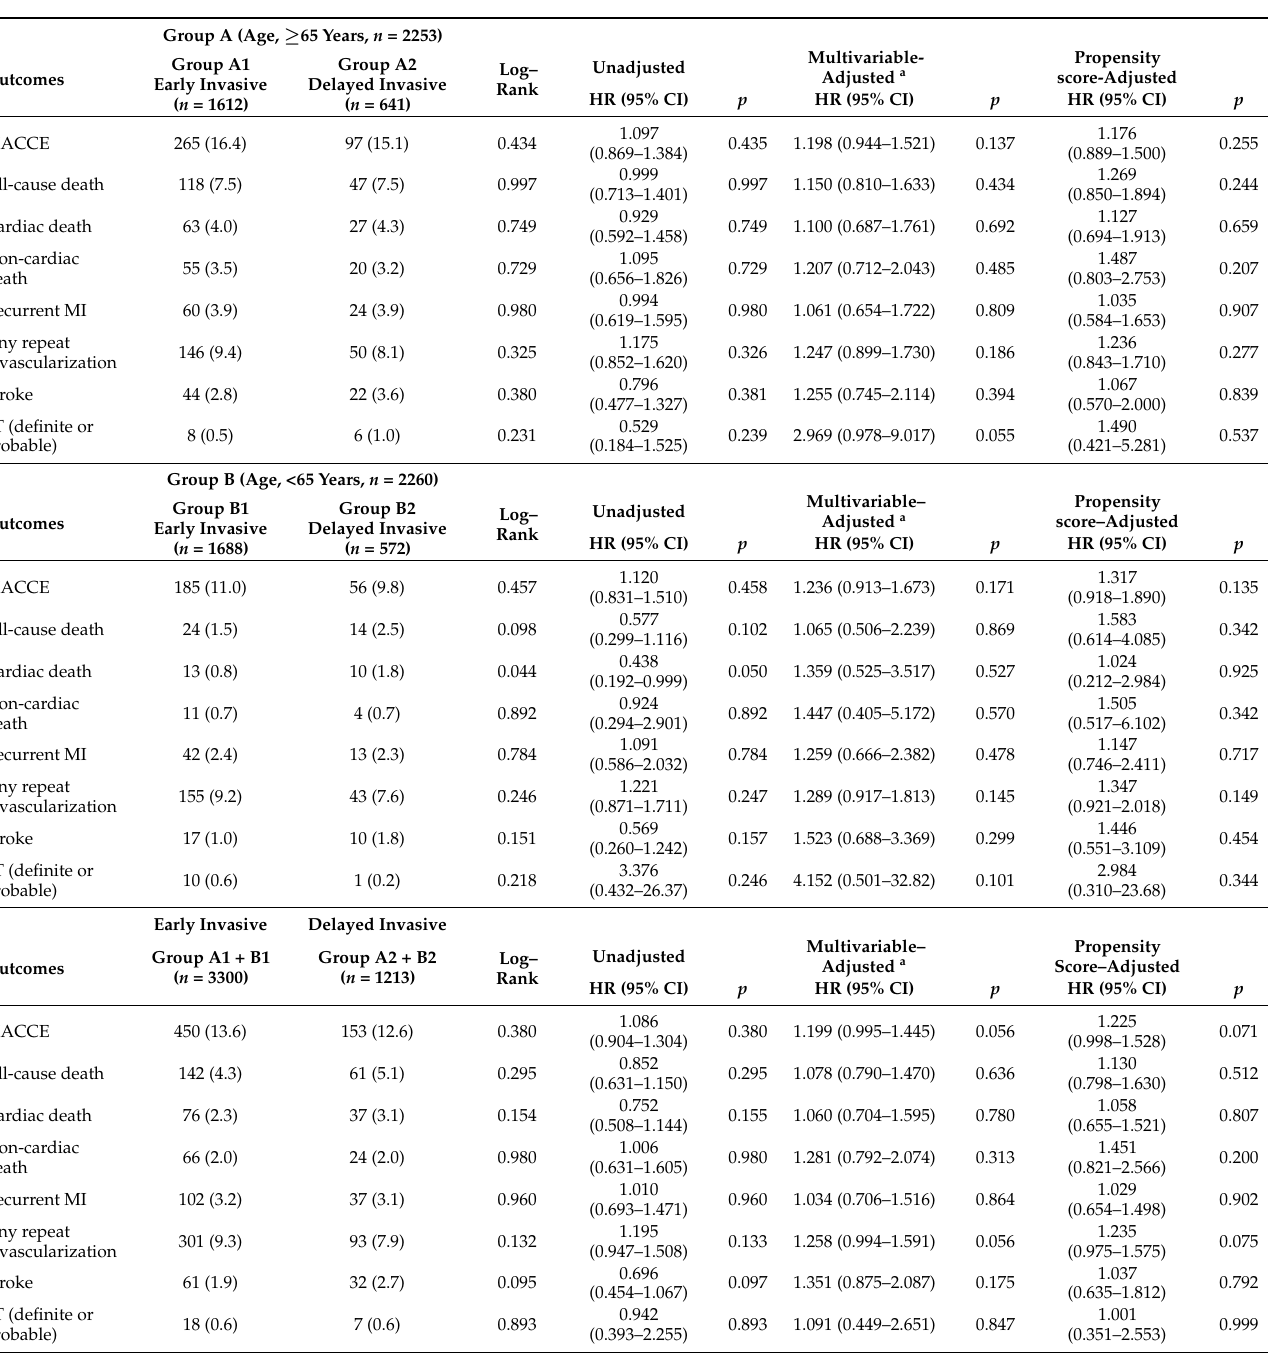
Table 2. Comparison of clinical outcomes at 2